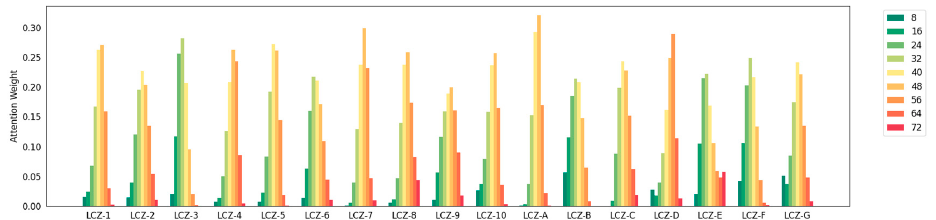
Figure 11. The statistics of scenes’ weights for correctly identified samples. Here, the color indicates the size of patch.